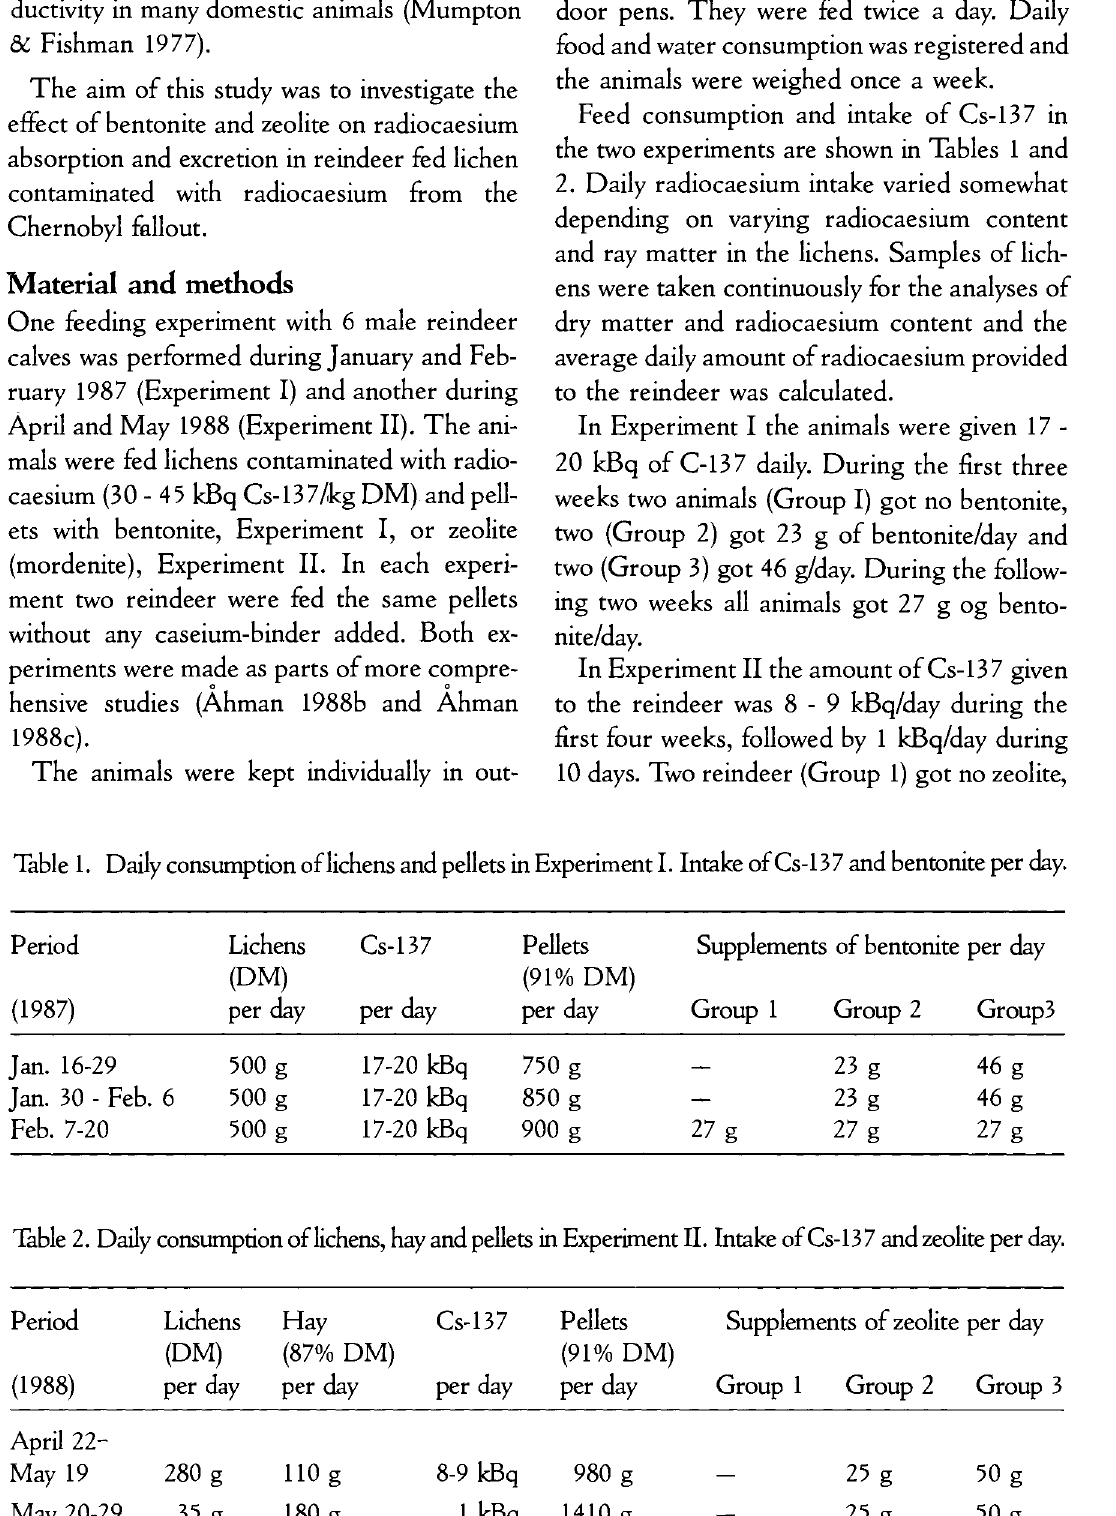
Table 2. Daily consumption of lichens, hay and pellets in Experiment II. Intake of Cs-137 and zeolite per day.